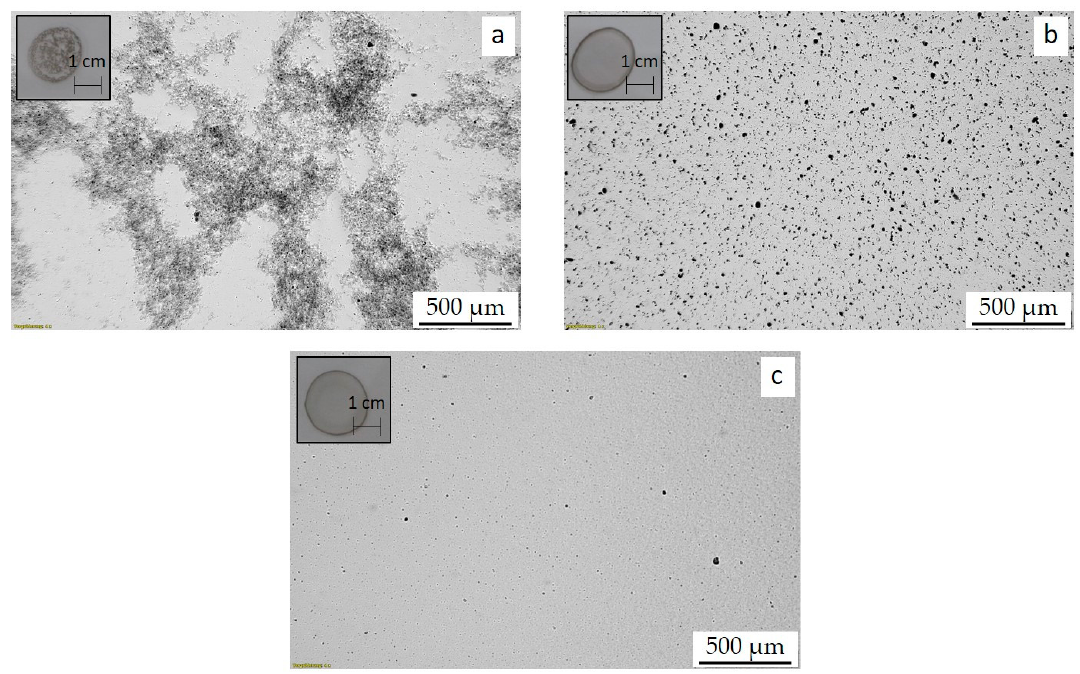
Figure 8. TLM images and inserted photographs of BCP composite films with 1wt % of MWCNTs in toluene prepared on glass substrates: ( a ) NC 7000, ( b ) CNT-PS, ( c )